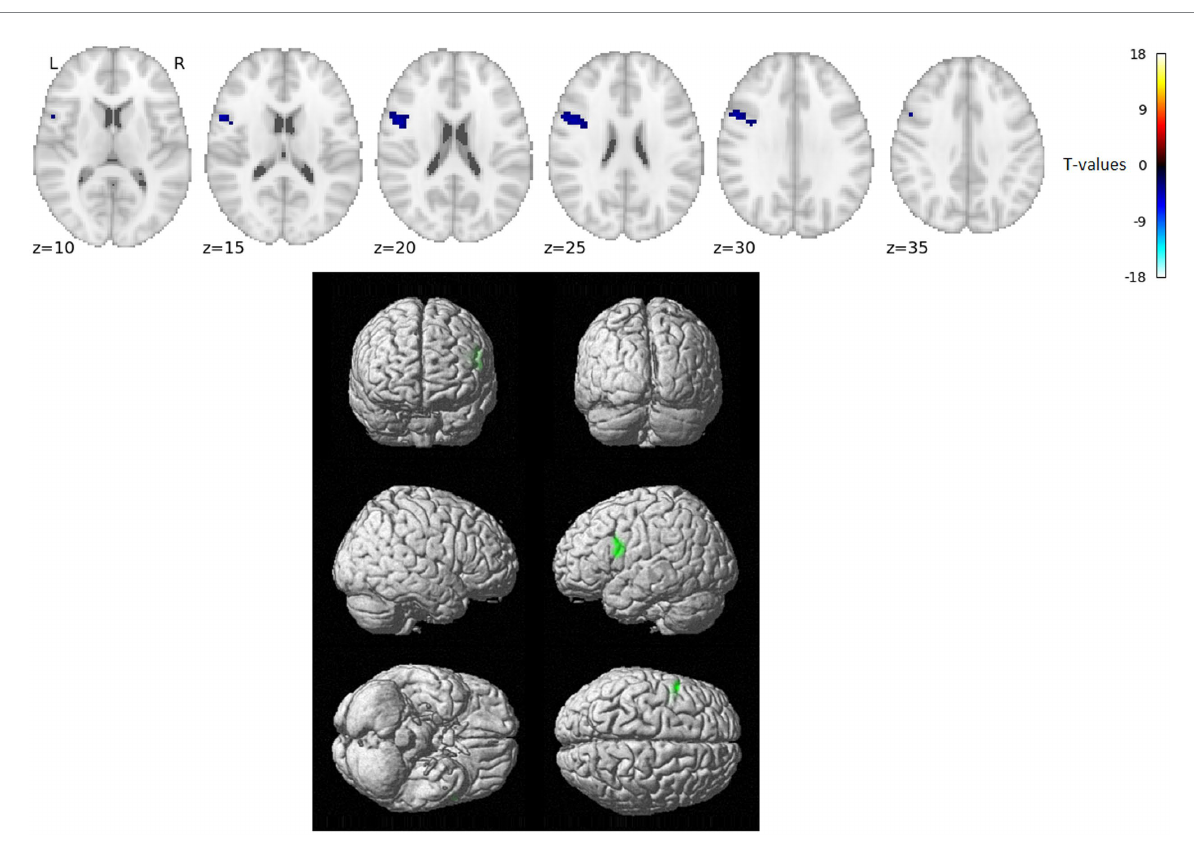
FIGURE 2 Statistically significant group effect of VWFA gPPI connectivity – reading words vs. reading nonwords after RT-related connectivity modulation effects were regressed out ( T -statistics). No VWFA connectivity stronger for reading words over and above RT effects was observed, blue/green indicates VWFA connectivity stronger for reading nonwords over and above RT effects. Thresholded with p = 0.005 uncorrected for multiple comparisons at the voxel level and subsequently with p = 0.05 FWE corrected at the cluster level. Positions of slices in the z-axis in MNI space are indicated below the slices; L and R mark the left and right side, respectively.